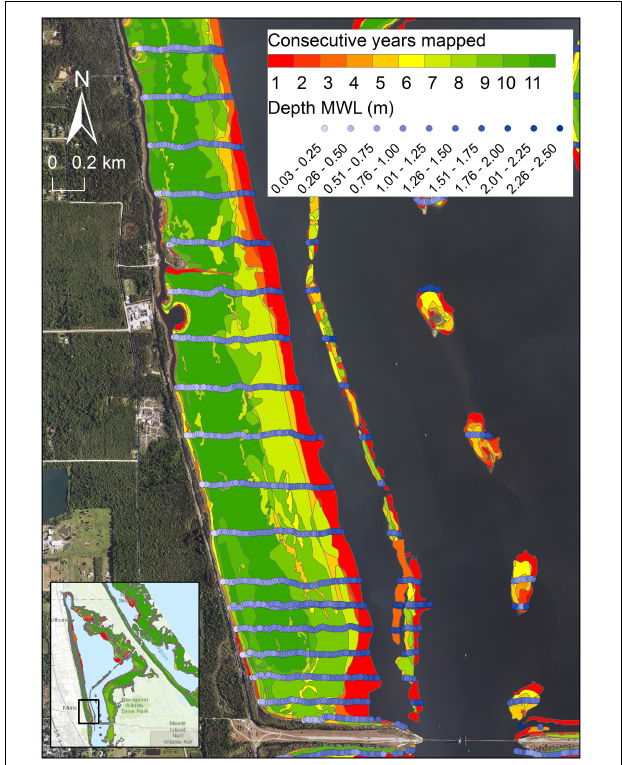
FIGURE 2 | An example of generating depths for seagrass polygons in northern Indian River Lagoon for determining persistence across differing numbers of map years. Blue circles represent individual measurements of